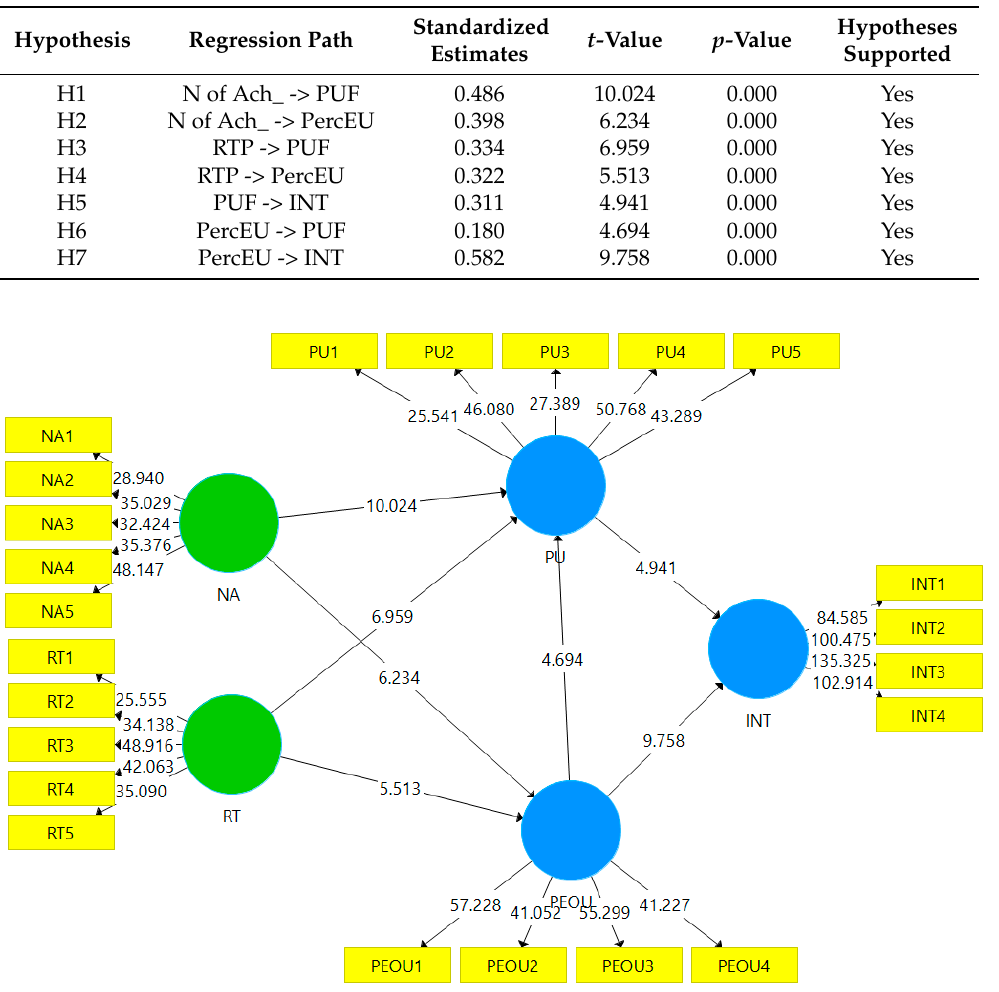
Table 5. The path coefficient and hypotheses.